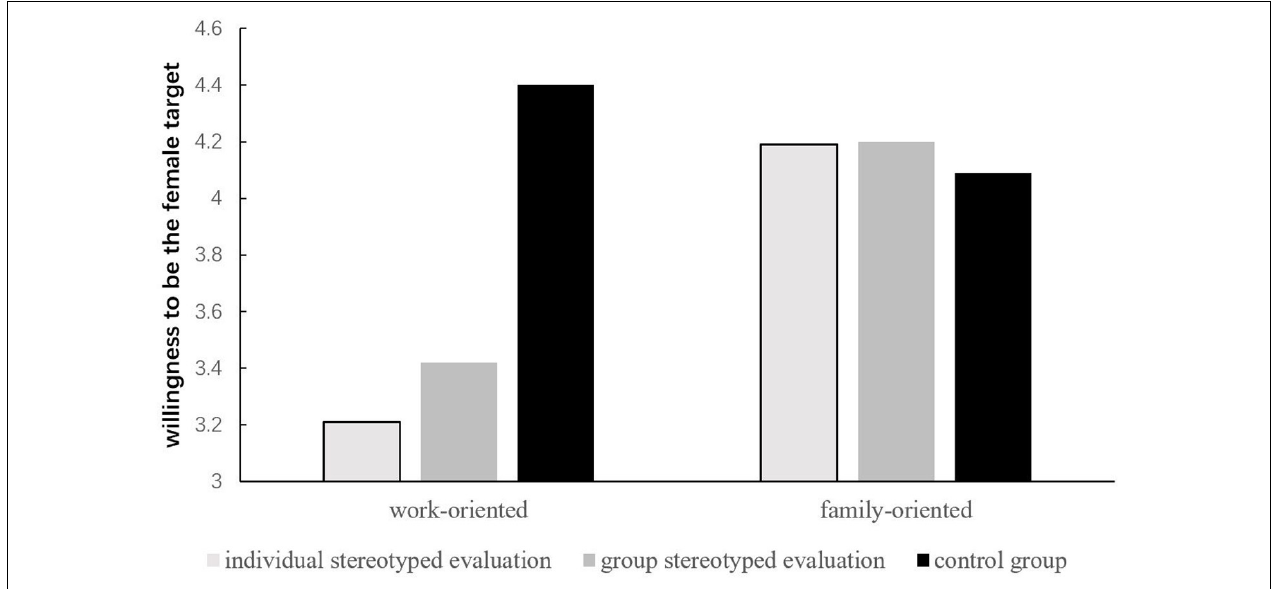
FIGURE 1 | Degree of willingness to be the female target who were evaluated by their male peer based on the positive